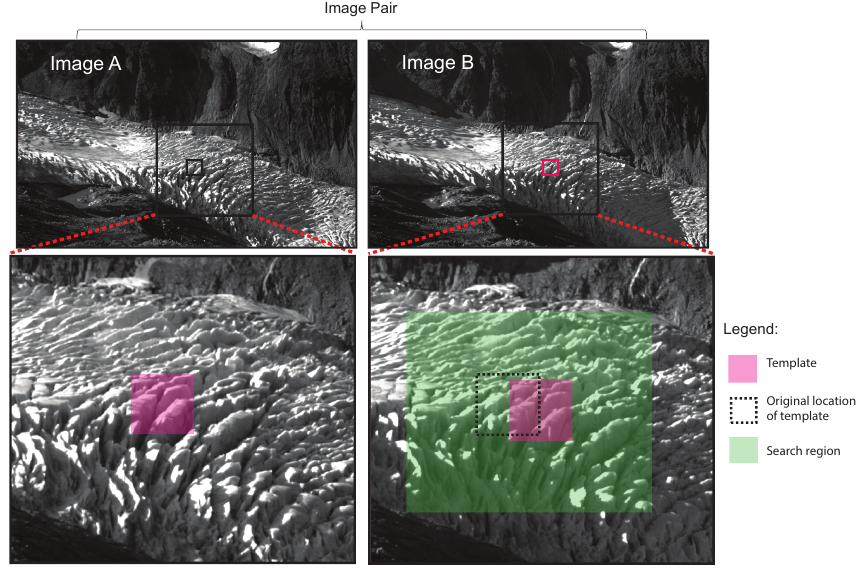
Figure 4. Schematic diagram to show the different components of the templatematch process. Note that the template and search region are not to scale. A unique template will be extracted from image A for every point defined in the grid (see Fig. 5). The user defines the size of both the template and the search region (Table 1).